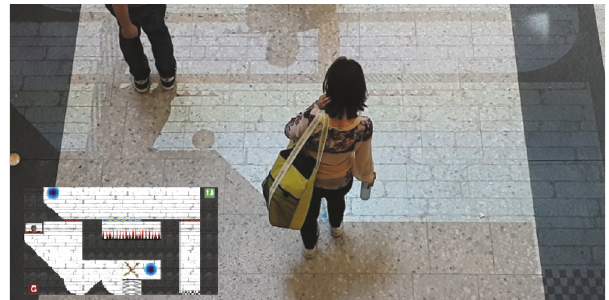
Figure 8: The Tower: participants collaborating on the level ele- mentstoguidetheballtothebottomrighttarget.Overlaidgameplay screenshot on bottom